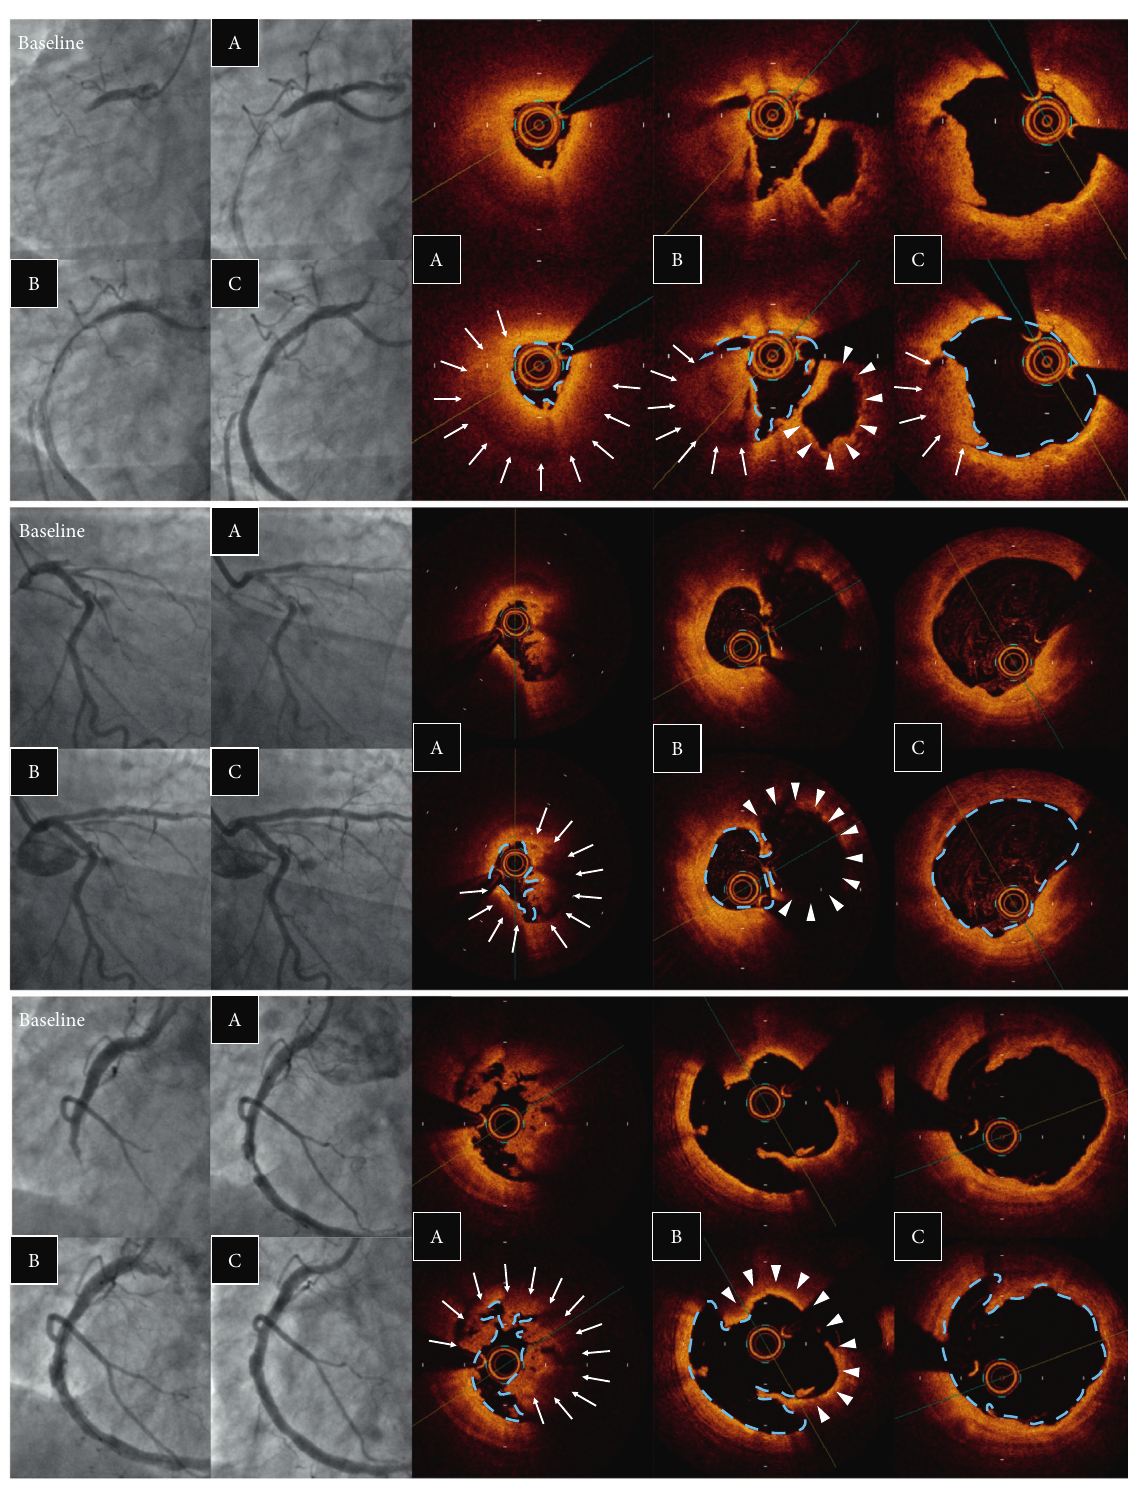
Figure 4: Examples of plaque rupture. Angiographic and OCTimages after (A) MT, (B) ELCA, and (C) ballooning. Laser vaporization of the thrombus (arrow) enabled the identification of the ruptured cavity (arrow head). ELCA, excimer laser coronary angioplasty; MT, manual aspiration thrombectomy; and OCT, optical coherence